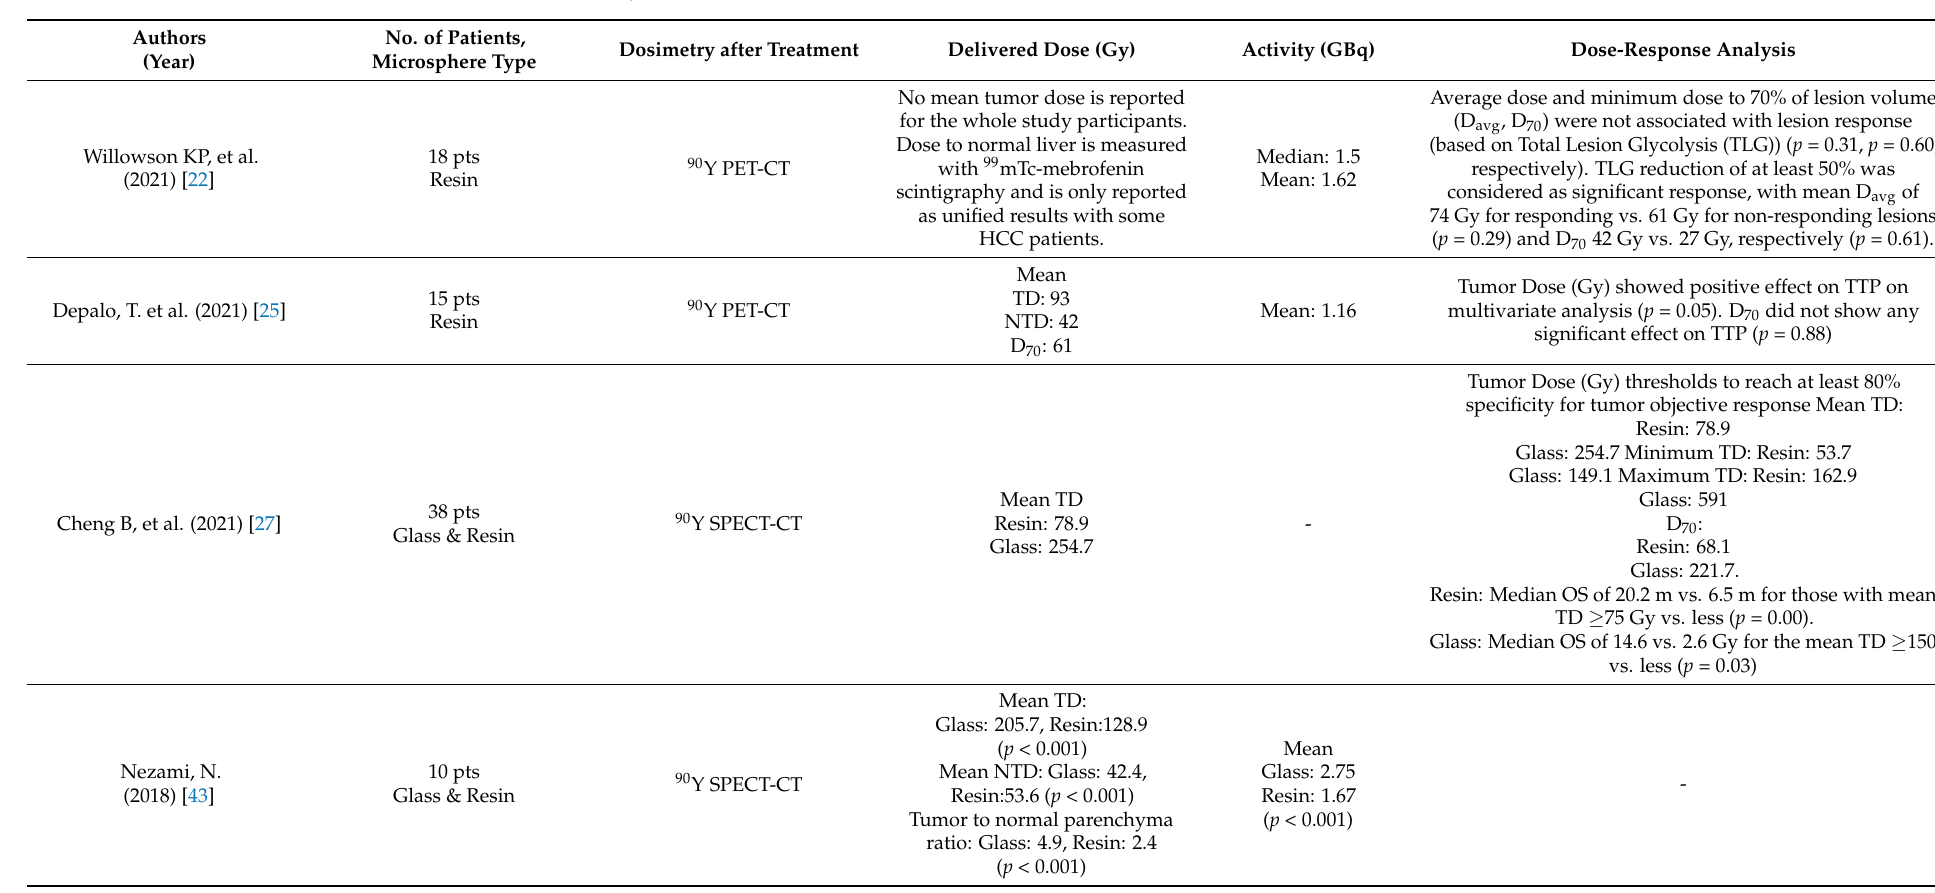
Table 4. Results of dosimetry verification